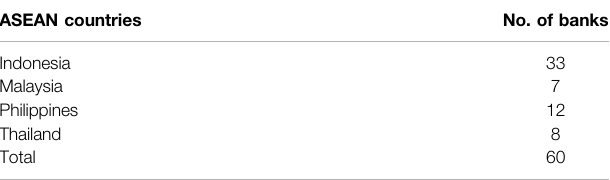
TABLE 1 | Selected countries and number of